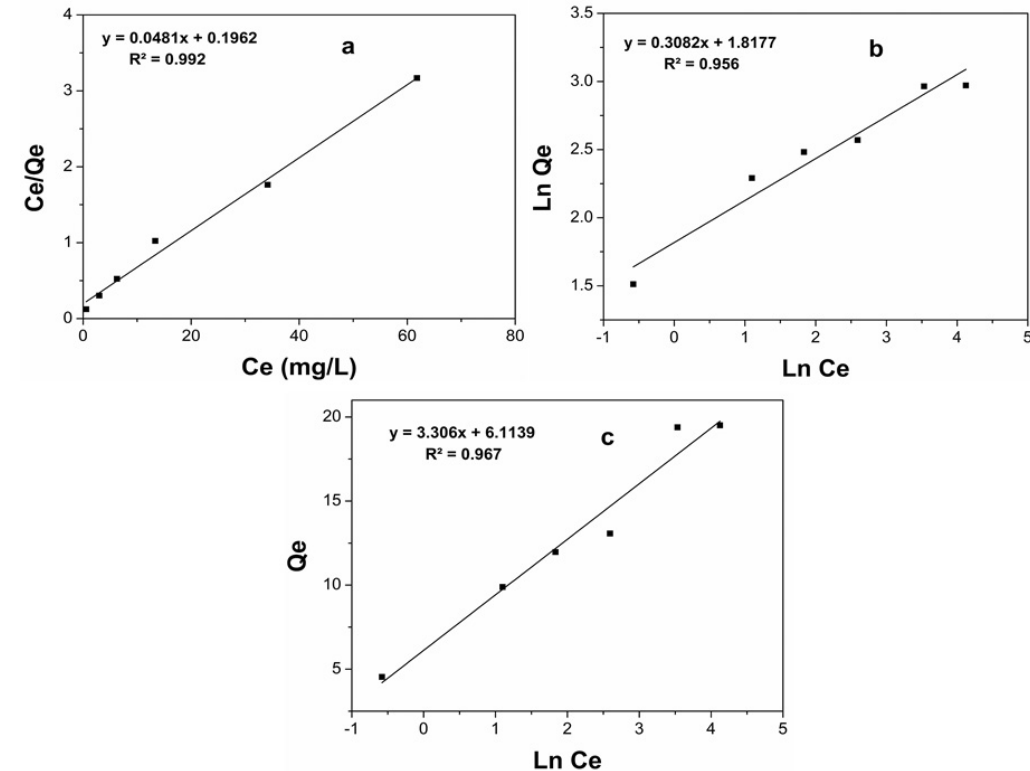
Fig. 8. Langmuir isotherm (a), Freundlich isotherm (b) and Temkin isotherm (c) for Mn (II) adsorption on OFIP adsorbent.